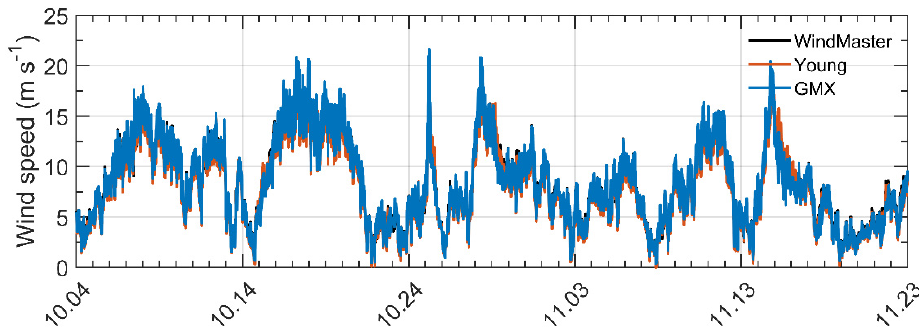
Figure 2. The wind speed at 30 m height. Black line: measured by sonic anemometers; Orange line: measured by HD monitor; Blue line: measured by AWS.